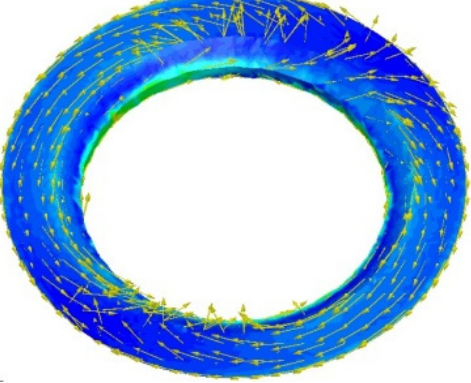
Figure 5. The path of eddy current.